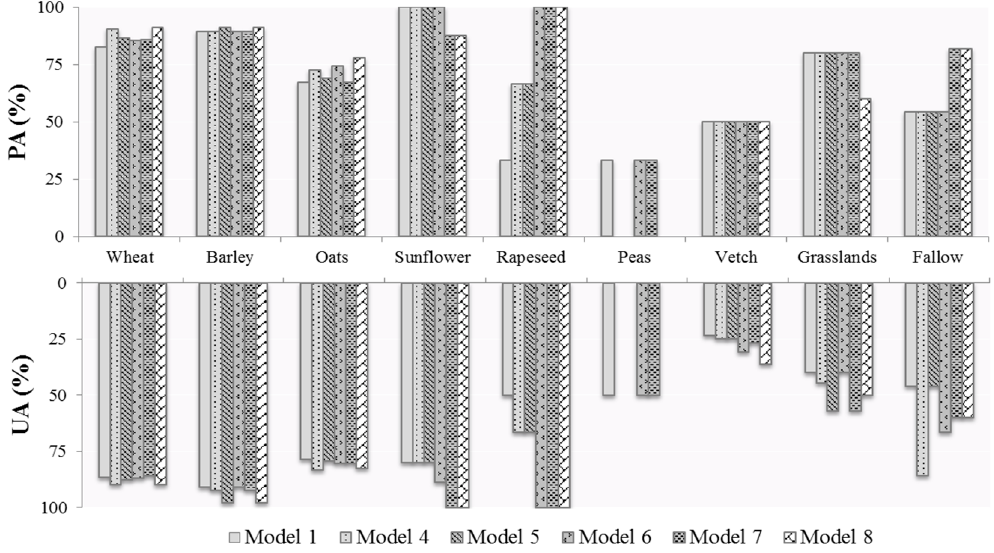
Figure 7. UA and PA for the different crops and classification schemes (models) including polarimetric features.